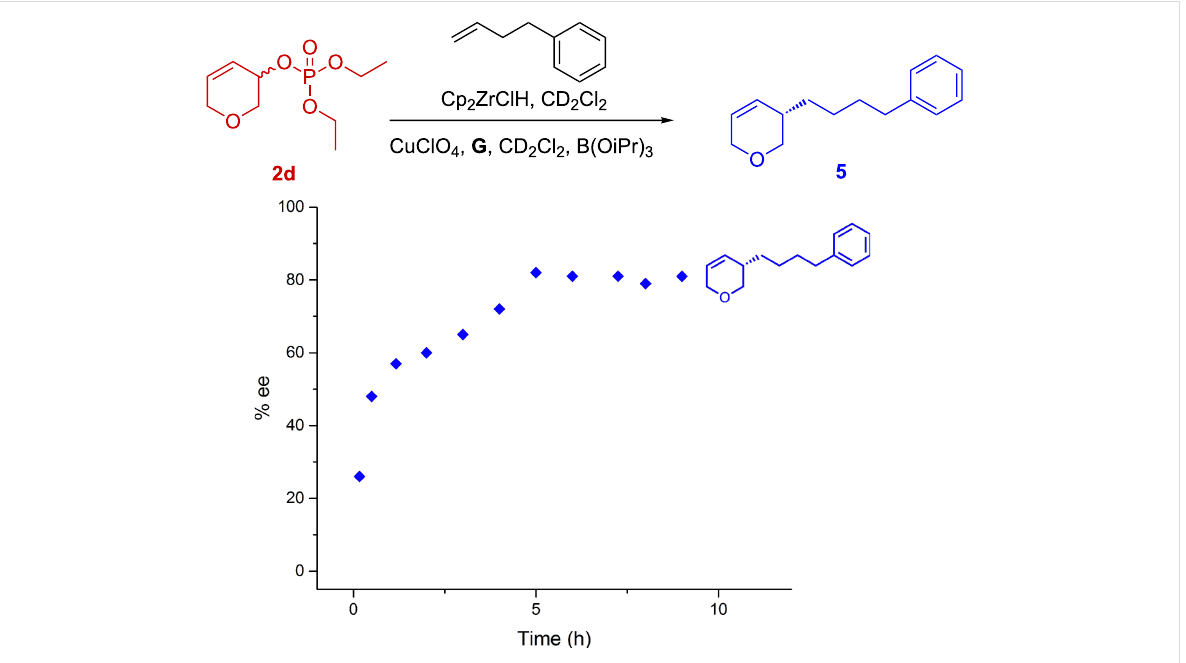
Figure 5: Kinetic ee analysis using 2d . ee of reaction with 3,6-dihydro-2 H -pyran-3-yl diethyl phosphate ( 2d ) as measured by removing aliquots in time.